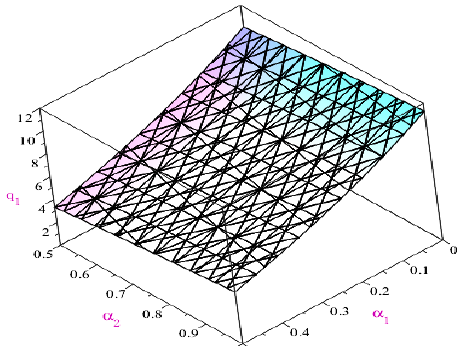
Figure 3. Changes of q ∗